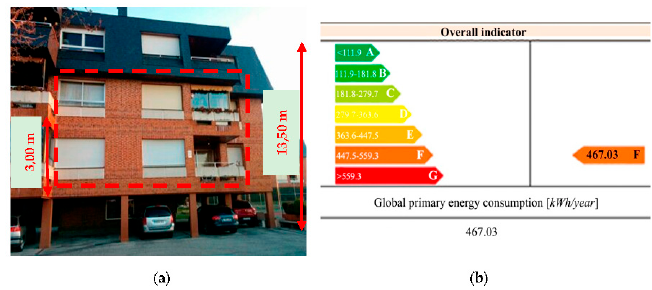
Figure 2. Analysed building. ( a ) Studied area; ( b ) Actual energy demand of each house. Table 2. Building materials properties.